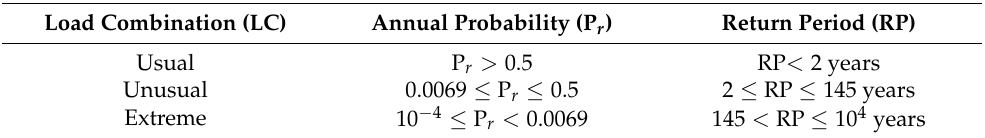
Table 3. Probabilities associated with load combinations (LCs).